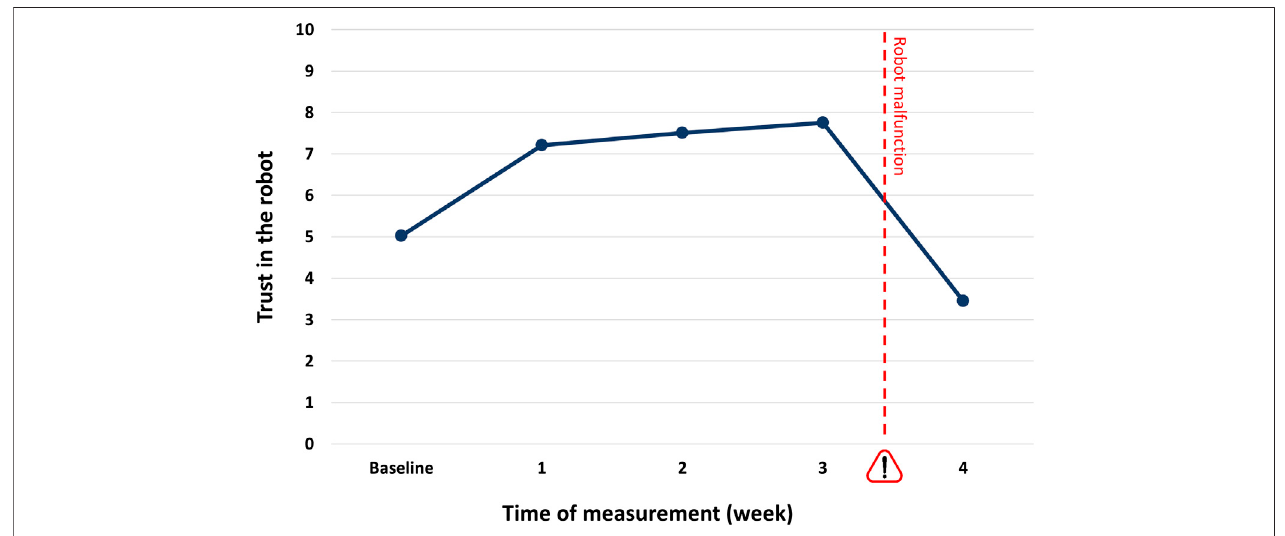
FIGURE 4 | Trust ratings (range: 0 – 10) for baseline and four measurement points. The pet feeding robot ’ s malfunction in the last week is indicated by the exclamation mark.